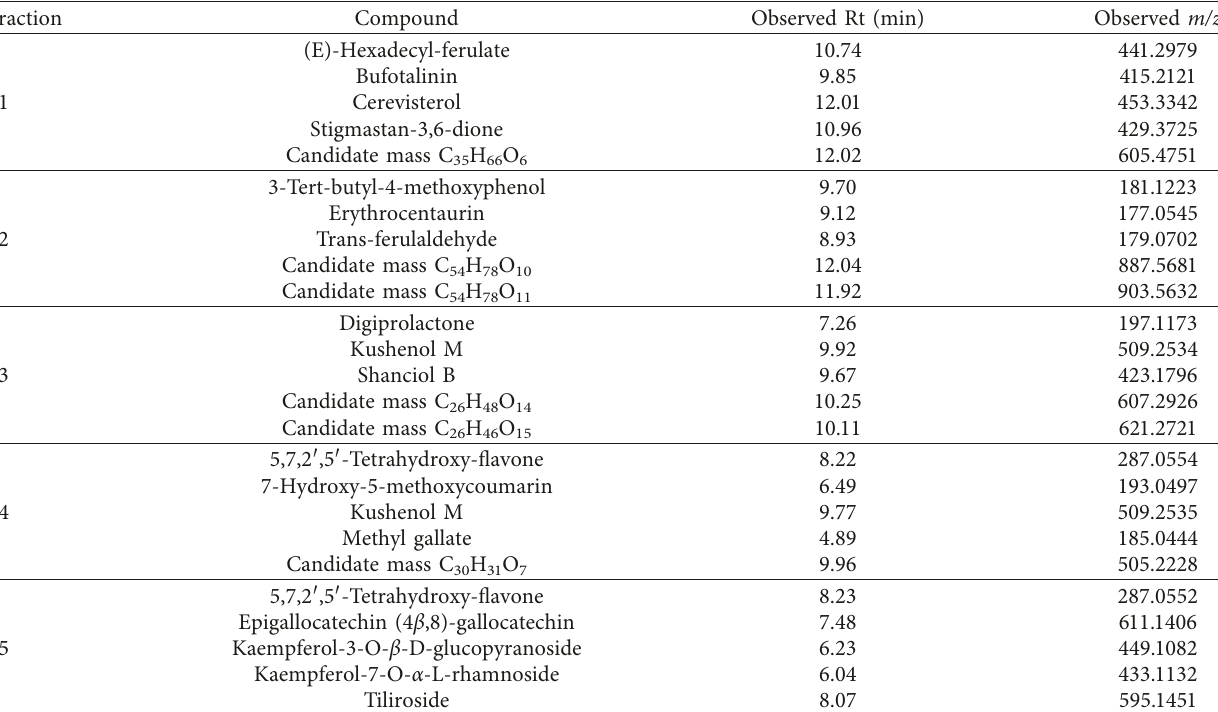
Table 2: Identification of compounds in M. peltata leaf extract fractions using liquid chromatography–mass spectrometry (LC-MS/MS). Fraction